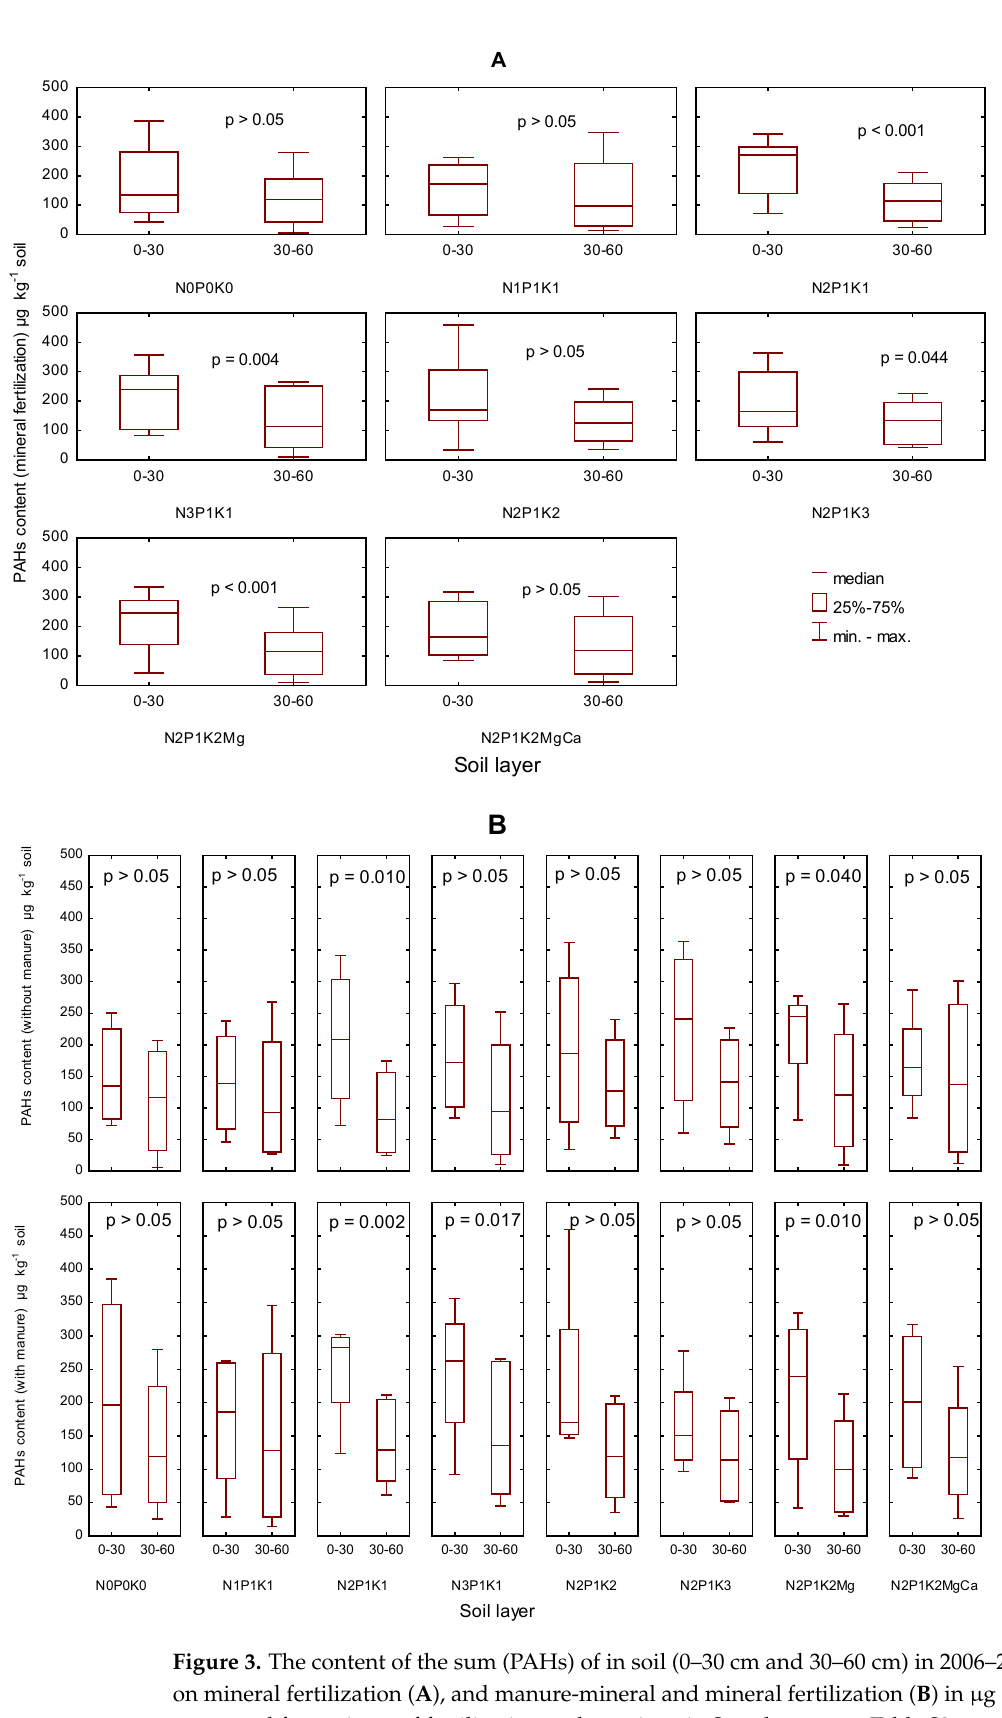
Figure 3. The content of the sum (PAHs) of in soil (0–30 cm and 30–60 cm) in 2006–2009 depending on mineral fertilization ( A ), and manure-mineral and mineral fertilization ( B ) in µg kg − 1 ; the codes were used for variants of fertilization and are given in Supplementary Table S2.